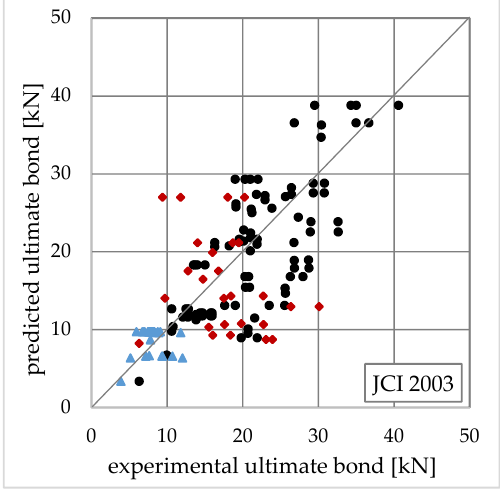
Figure 22. Test vs. predicted bond force using the JCI 2003 model [35].